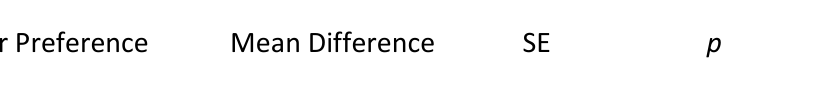
Table 6. Differences in Perceived Usefulness between Augmented and Virtual Reality Interface by Learner